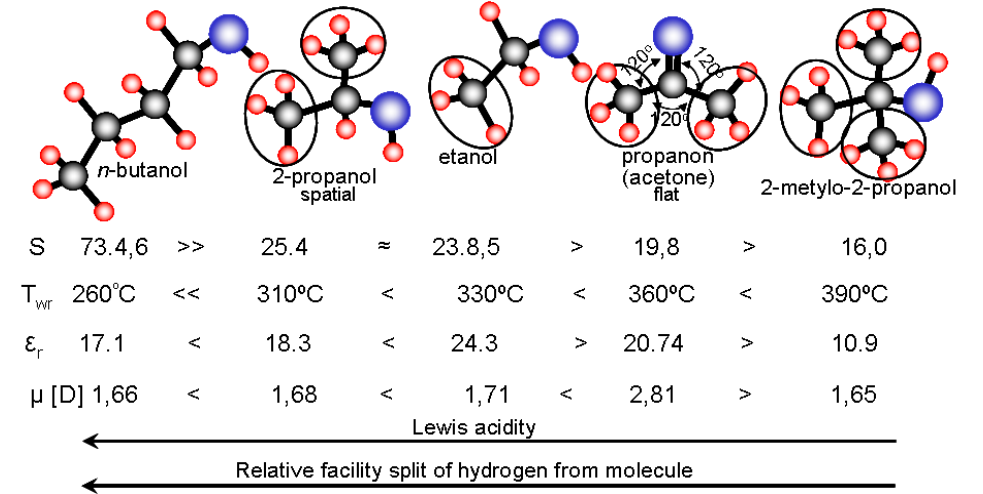
Figure 9. Shape of examined organic compounds, sensitivity and working temperature of sensors, dipole moment and relative electric permittivity as well as the changes in Lewis acidity and relative ease of removing of hydrogen atom from molecule